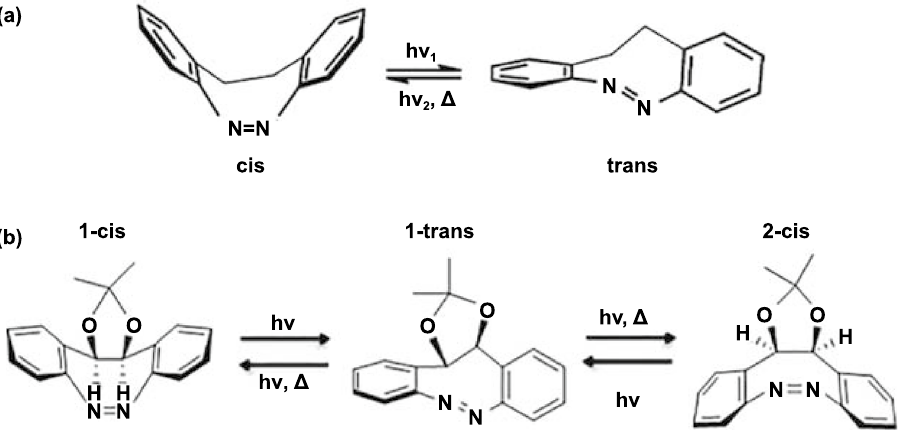
Fig. 7 Scheme a [91] and scheme b